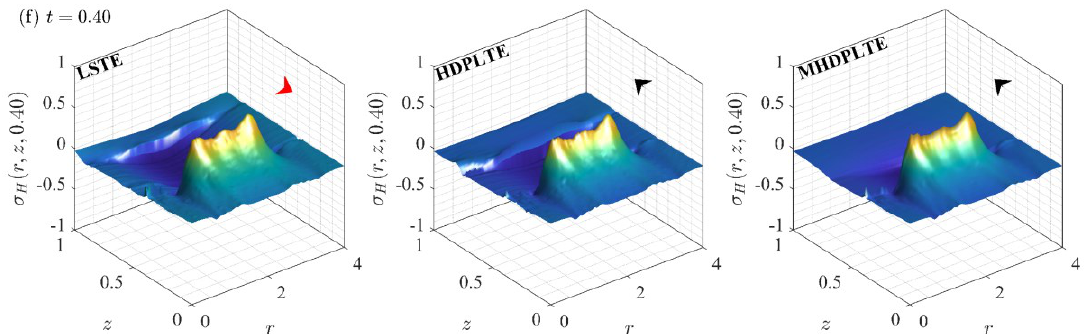
Figure 3. Temporal evolution of the hydrostatic stress on the space-time domain under the three theories of hyperbolic thermoelasticity, LSTE, HDPLTE and MHDPLTE: ( a ) Hydrostatic stress at 𝑡 = 0.03 , ( b ) 𝑡 = 0.05 , ( c ) 𝑡 = 0.15 , ( d ) 𝑡 = 0.27 , ( e ) 𝑡 = 0.3 , and ( f ) 𝑡 = 0.4 .